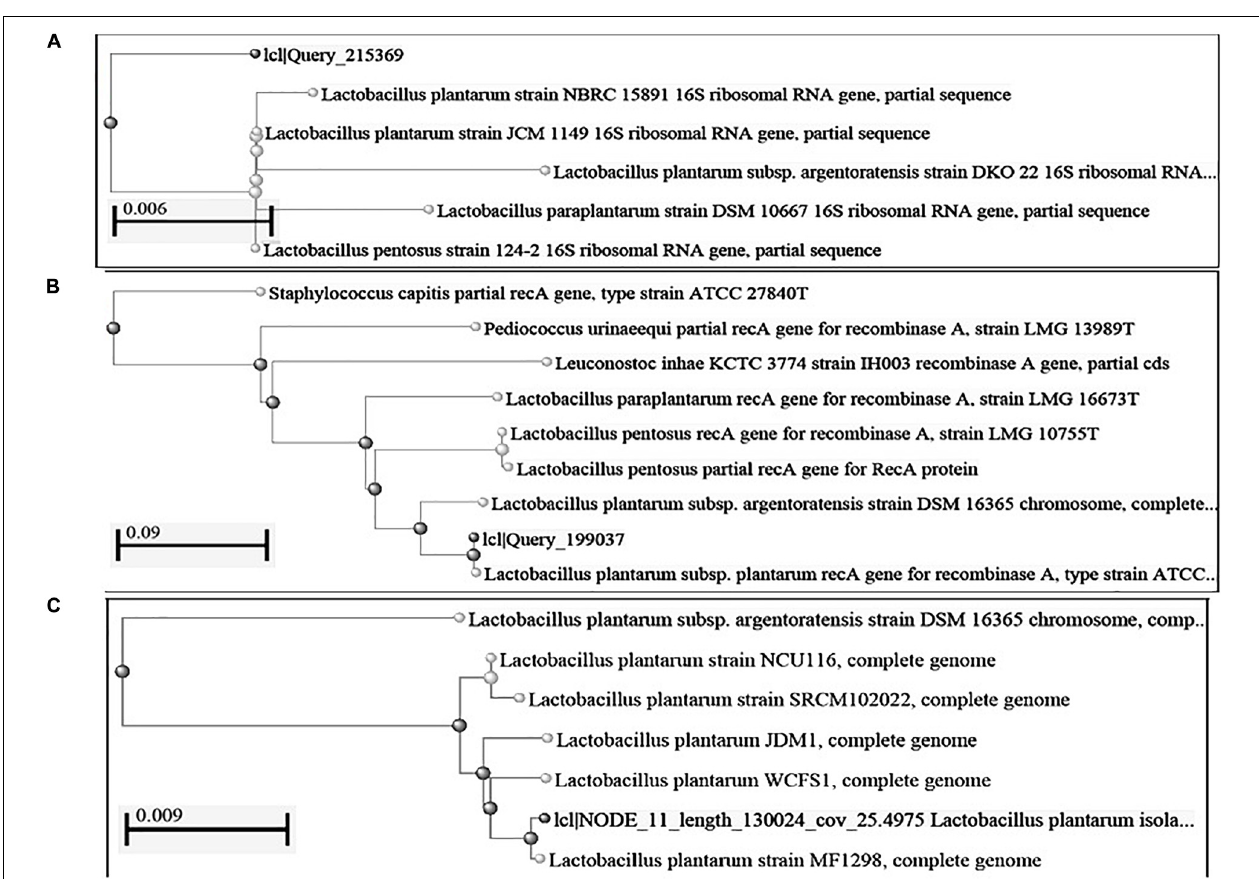
FIGURE 1 | Construction of phylogenetic tree using NCBI Database by Neighbor-Joining method (A) 16S rRNA gene; (B) : rec A gene sequence; (C) : complete genome